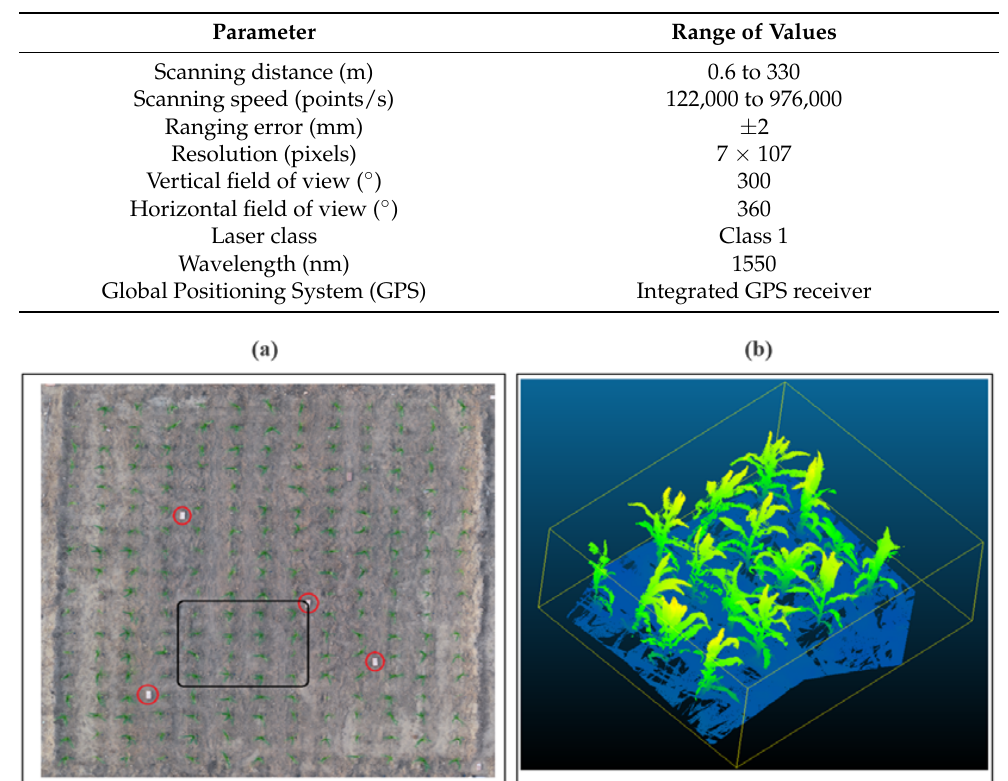
Table 1. The parameters of the FARO Focus3D x330 LiDAR (Light Detection and Ranging) surveying instrument.